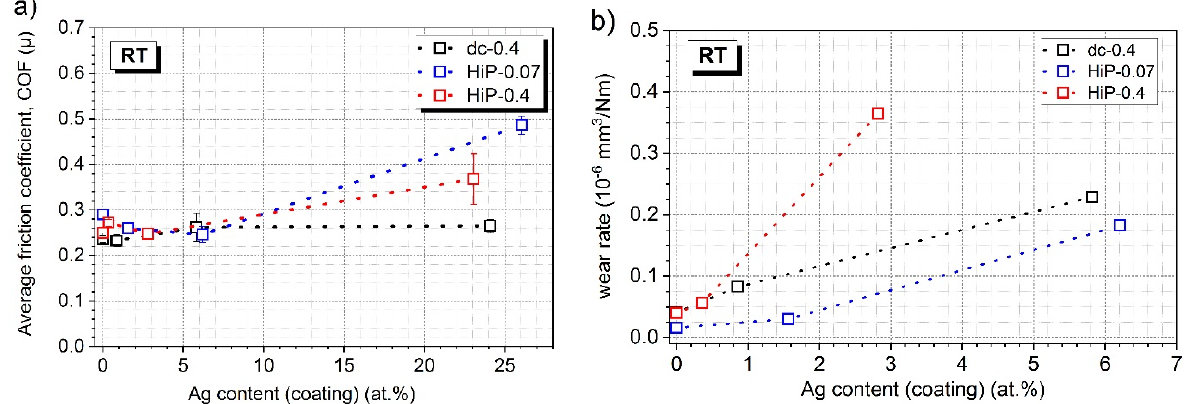
Figure 12. COF ( a ) and wear rate ( b ) of MoN-Ag coated steel vs. Ag content studied by pin-on-disc tests with Al 2 O 3 counterpart at room temperature (30,000 rotations).